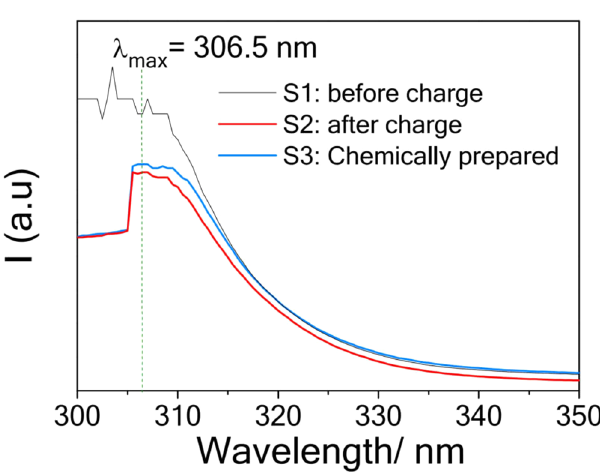
Figure 3. Current vs. time profile during CV cycling (voltage sweeping rate v = 2.5 × 10 − 4 V/s).